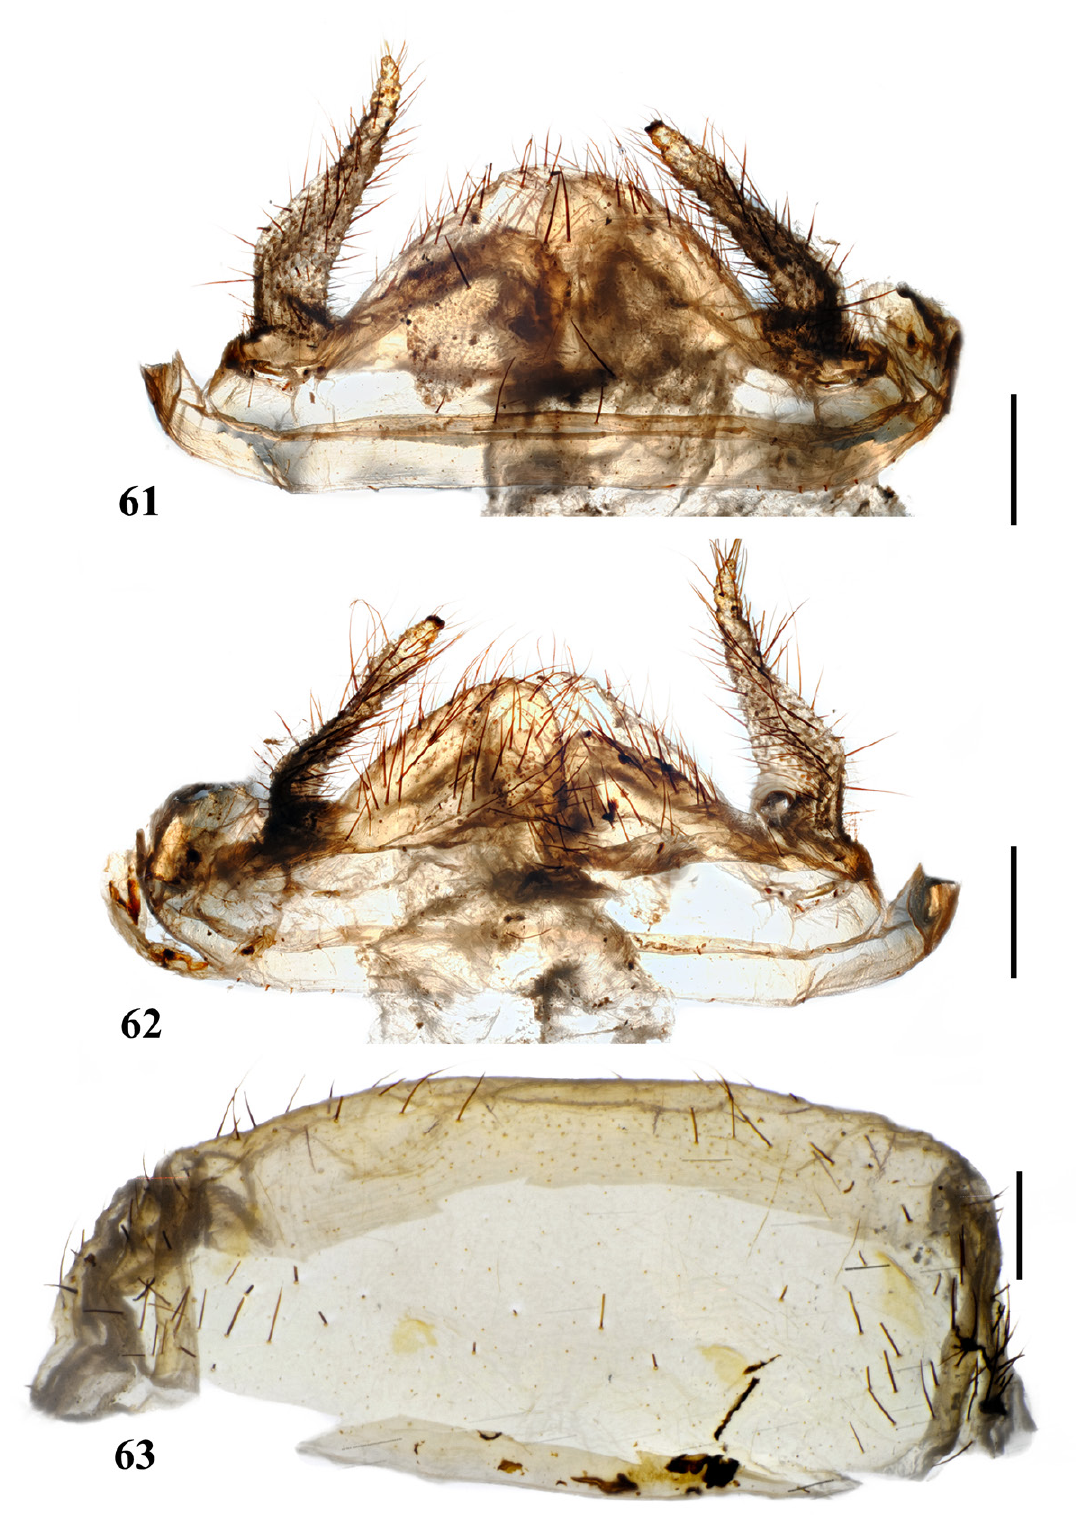
Figs 61–63. Oryctopterus yeshwanthi sp. nov. Female genitalia. Holotype (UASB). 61 . Supragenital plate, dorsal view (macerated specimen). 62 . Supragenital plate, ventral view (macerated specimen). 63 . Subgenital plate, dorsal view (macerated specimen). Scale bars = 1